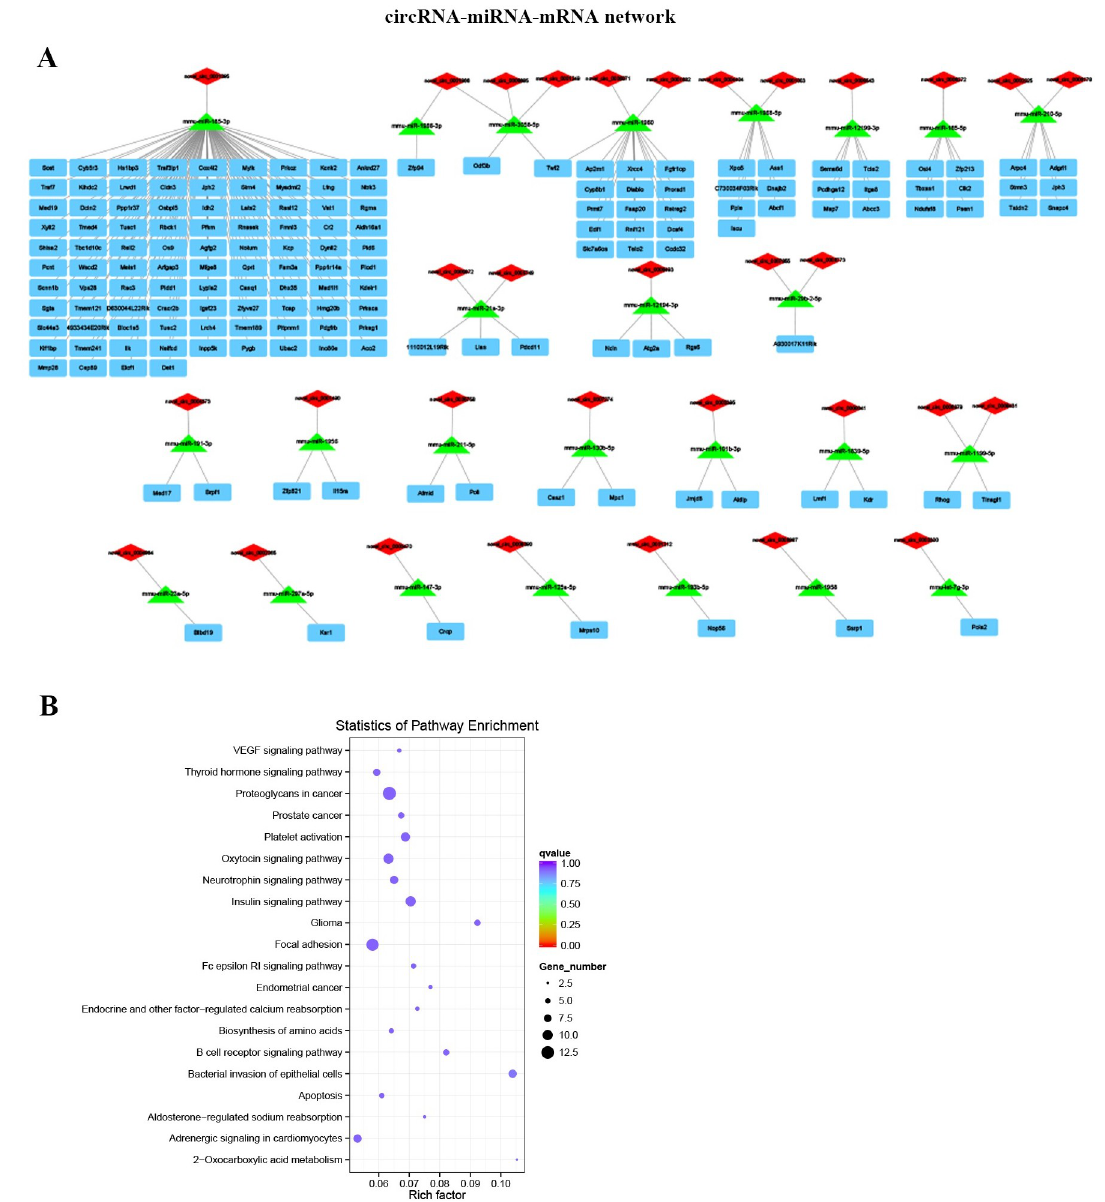
Fig 7. Established circRNA-miRNA-mRNA network in ALI mouse model. (A) Illustration of the circRNA-miRNA-mRNA networks. (B) The bubble plots of KEGG pathway enrichment of DE mRNAs that associated in circRNA-miRNA-mRNA network.